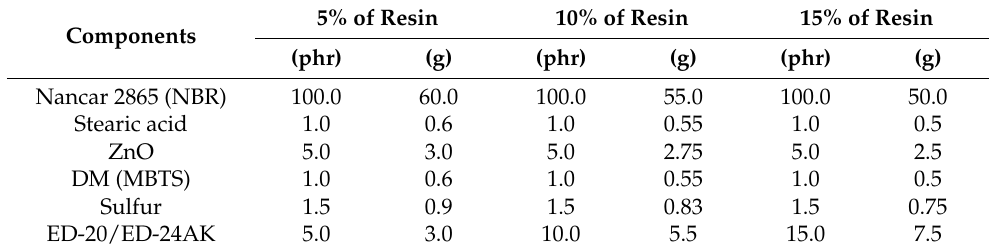
Table 1. Composition of the rubber mixes studied